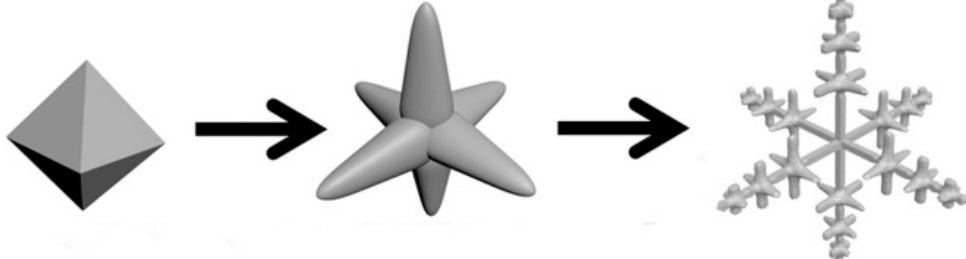
Figure 1. Illustration of silver chloride the shape transformation from octahedra to hexapod with mace pods.